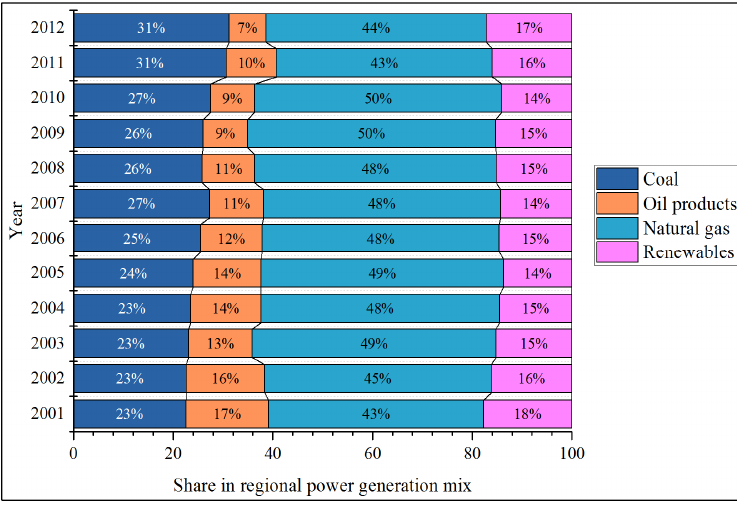
Figure 20. ASEAN: power generation